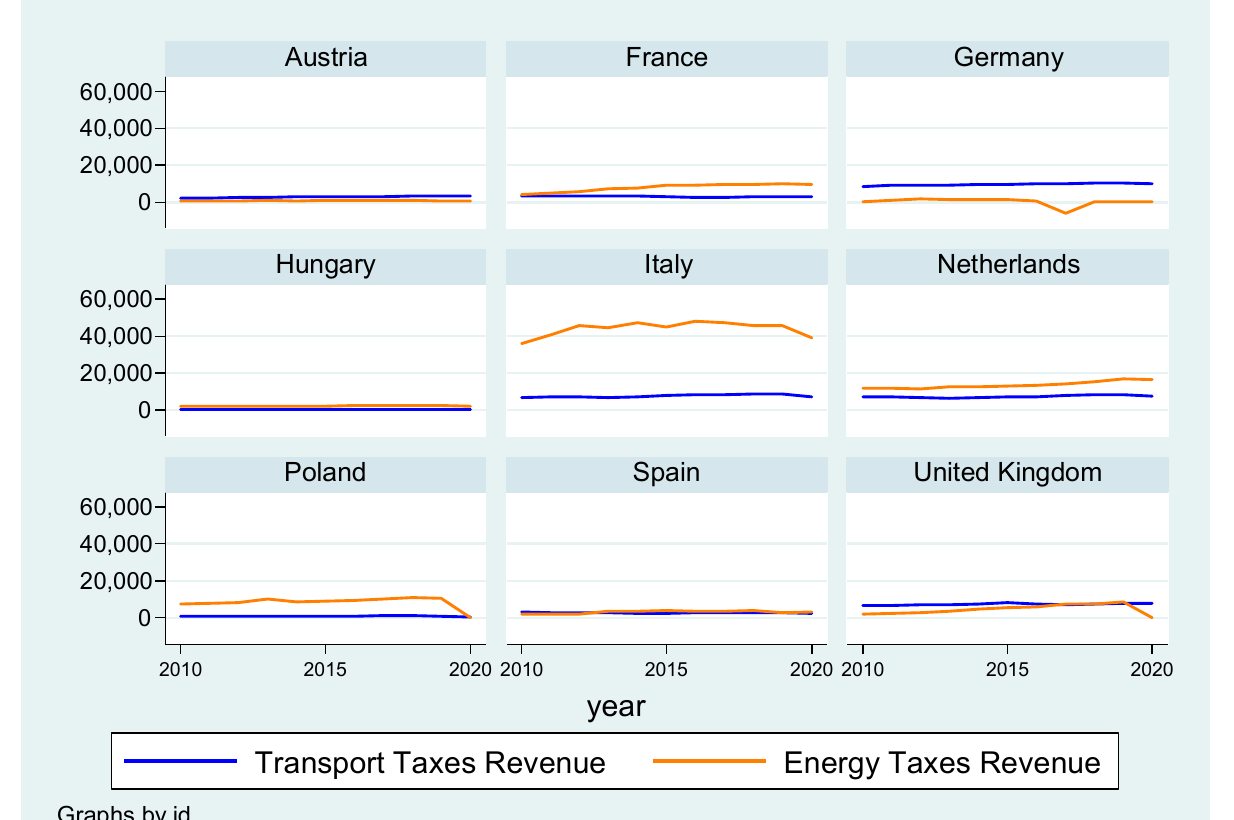
Figure 3. Dynamics of the revenues from transport and energy taxes in the European countries for 2010–2020, mln US dollars. Note: built based on the data from https://pinedatabase.oecd.org/Default.aspx, accessed on 10 July 2022.